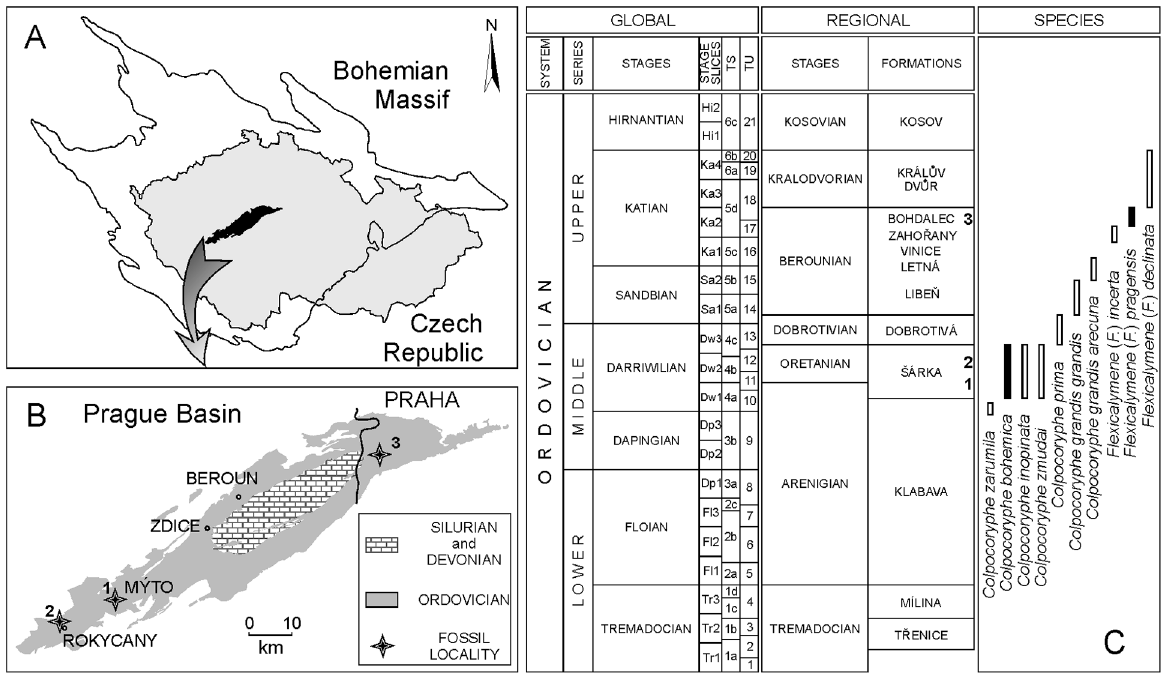
Fig. 1. Location of discovery sites, and the Ordovician stratigraphy in the Barrandian area. A , map of the Czech Republic and the Bohemian Massif showing the distribution of Ordovician rocks in the Barrandian area. B , Ordovician of the Prague Basin with the location of three outcrops that yielded the studied specimens: 1, field near Mýto; 2, fields north of Rokycany; 3, Brumlovka locality. C , chart showing the correlation between global series, stages, stage slices, time slices (TS), time units (TU) and the regional chronostratigraphic and lithostratigraphic units recognized in the Ordovician of the Prague Basin, and ranges of species of Colpocoryphe and Flexicalymene (stratigraphy modified from Bergström et al. 2008, Fatka et al. 2013 and Vodi č ka et al. in